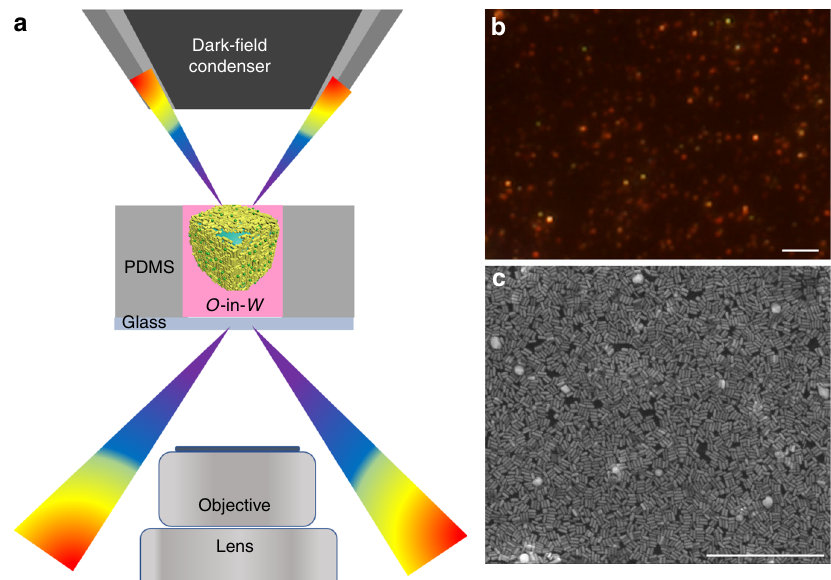
Fig. 4 Interfacial morphology of GNR arrays. a Dark- fi eld imaging setup for metal liquid-like O- in -W GNR arrays in PDMS cavity. b DFM image of interfacial GNRs at 0.6 OD of 1 mL sols. The scale bar is 4 μ m. c SEM image of close-packed GNR fi lm dried on silicon wafer fabricated from 1 mL of 7 OD GNR sols. The scale bar is 1 μ